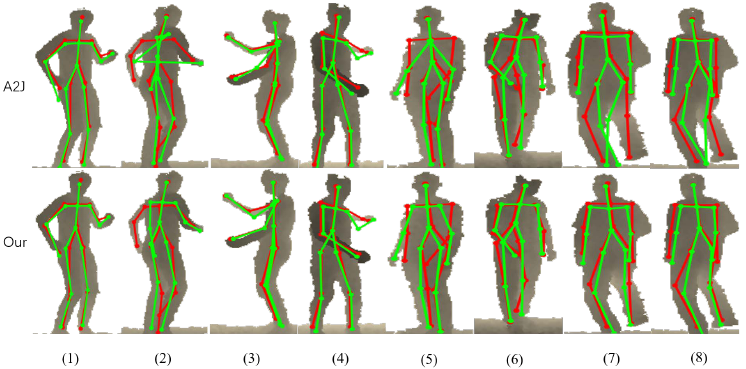
Figure 6. The comparison visualization results with A2J in the 2D plane on the ITOP front dataset. The ground-truth is shown in red, and the estimated result is in